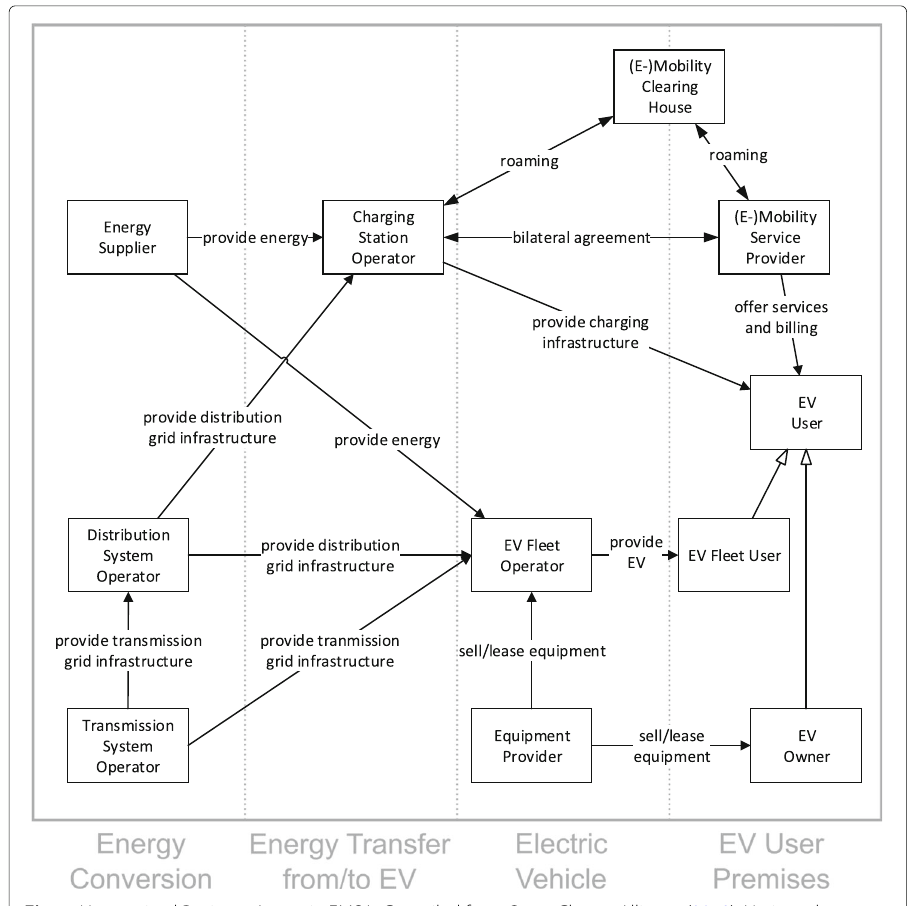
Fig. 4 Harmonized Business Actors in EMSA. Compiled from Open Charge Alliance (2018); Nationaal Kennisplatform Laadinfrastructuur et al. (2019); ISO Central Secretary